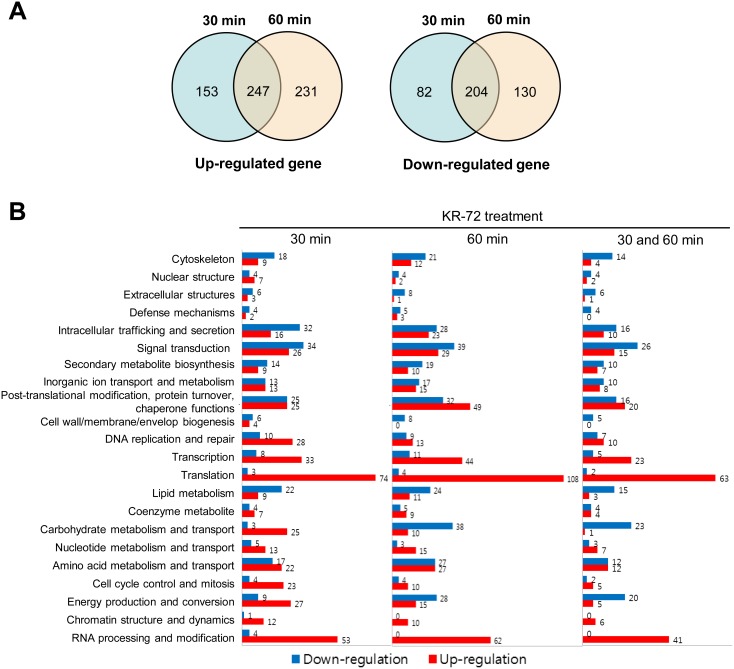
Functional categories of KR-72-responsive genes in C. neoformans.
(a) Venn diagrams showing number of upregulated (left diagram) and downregulated C. neoformans genes (right diagram) with 30 min and 60 min treatment of KR-72. The number was counted only for genes whose expression levels were significantly changed (ANOVA, P<0.05). (b) Functional categories of KR-72 responsive genes in C. neoformans. Among the KR-72 responsive genes, genes whose expression was changed more than 1.5-fold were functionally categorized based on the COG (eukaryotic Cluster of Orthologous Groups of proteins, http://www.ncbi.nlm/nih.gov/COG/) functional description. The red and blue bars indicate the number of up-regulated and down-regulated genes by KR-72, respectively.